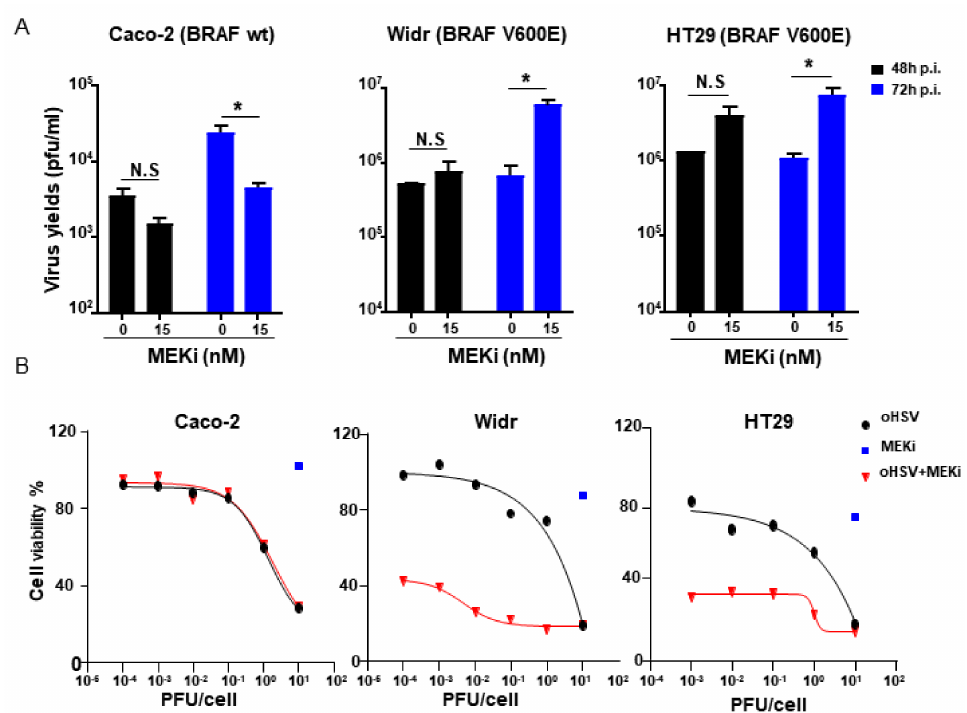
Figure 1. MEK inhibitor (MEKi) Trametinib treatment promoted oHSV replication and tumor cell killing in BRAF V600E- mutated tumor cells. ( A ) Caco-2, Widr, and HT29 cells were pretreated with 15 nM of Trametinib (MEKi) for 2 h and then infected with T1012G at 0.01 PFU/cell. The infected cell pellets were harvested at 48 and 72 h post-infection, respectively. The titration was measured by conventional plaque assay on Vero cells after three freeze–thaw cycles. ( B ) The tumor cell killing activity was assessed using a CCK8 assay. Caco-2, Widr, and HT29 cells were mock treated or pretreated with 15 nM of Trametinib (MEKi) for 2 h and then infected with T1012G at an indicated MOI or MEKi only treated. Cell viability of infected cells was measured with a CCK8 assay (mean ± SD) 48 h after infection. The assay was performed in triplicate. N.S. (not significant); p > 0.05, * p <